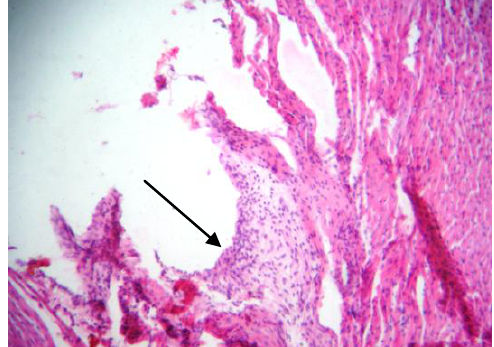
Fig (9): liver at day 6 reveals focal aggregation of inflammatory cells mainly lymphocyte ( ) ( H&EX10).